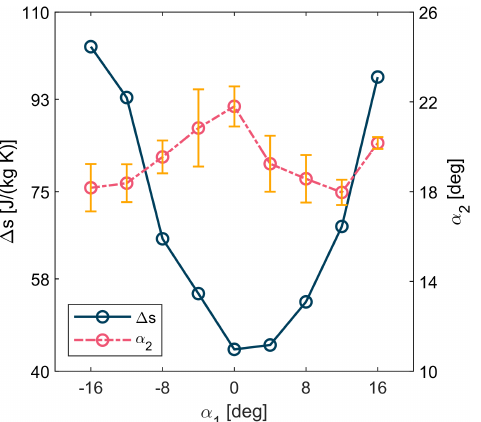
Figure 13. Entropy production and stator outlet angle with its standard deviation calculated at the outlet section mid-span for different inlet flow angles.